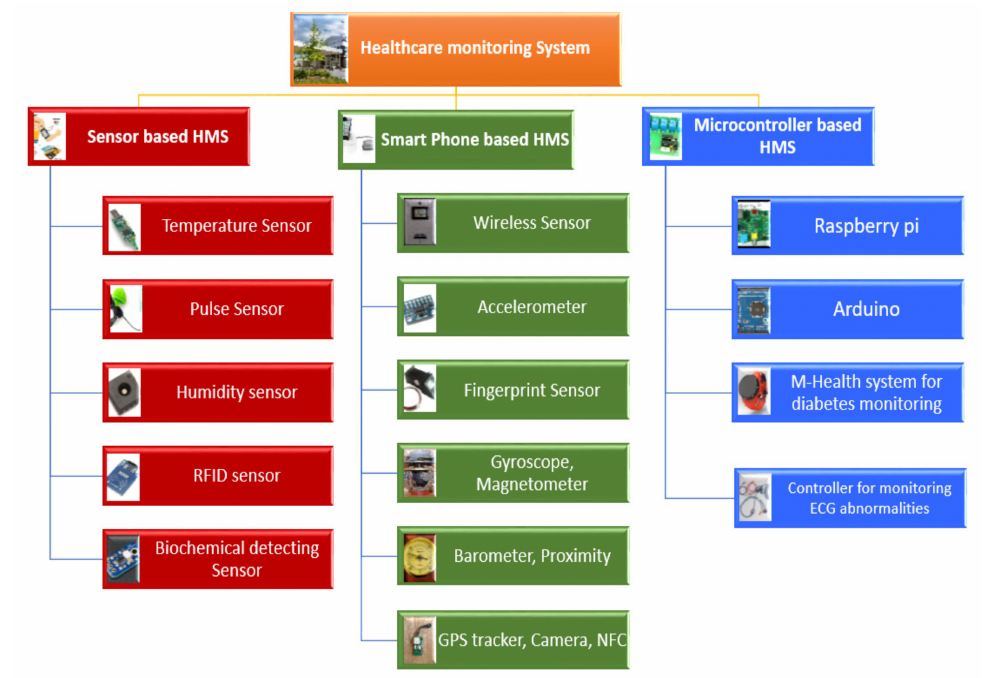
Figure 3. A taxonomy of sensors used for healthcare monitoring.